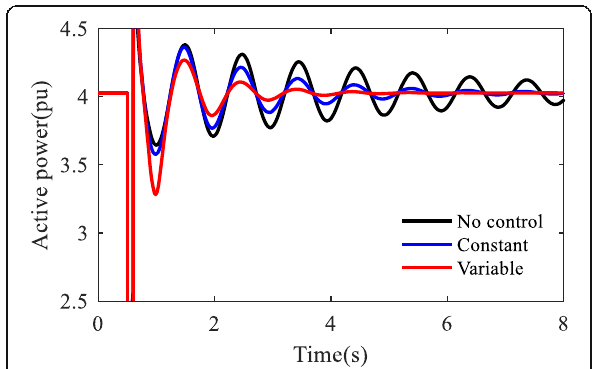
Fig. 11 The active power output of the SG when the output power of the PV is 0.9 pu